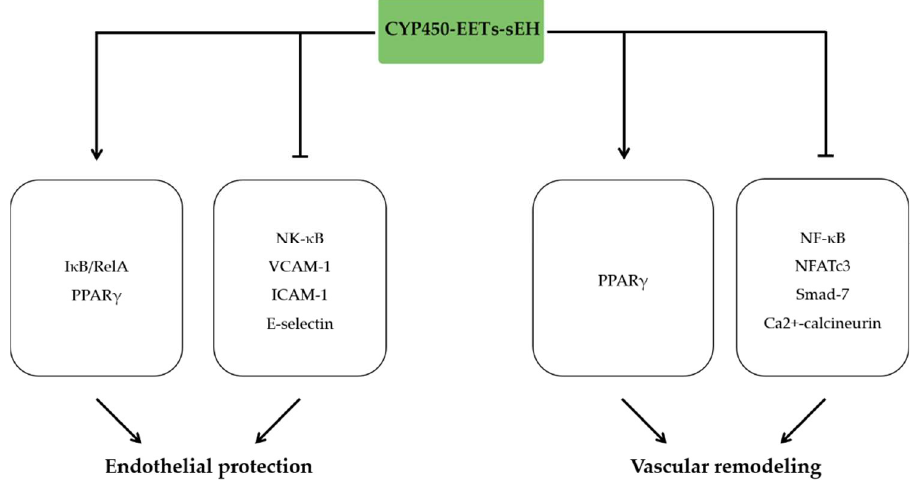
Figure 3. The anti-inflammatory effects of EETs in vascular disease. EETs alleviate endothelial dys- function by activating PPARγ, IκB activation, RelA translocation, and inhibiting NF-κB, VCAM-1, ICAM-1, E-selectin expression. EETs attenuate vascular remodeling by increasing PPARγ signaling pathway and inhibiting NF-κB, NFATc3, and Smad-7